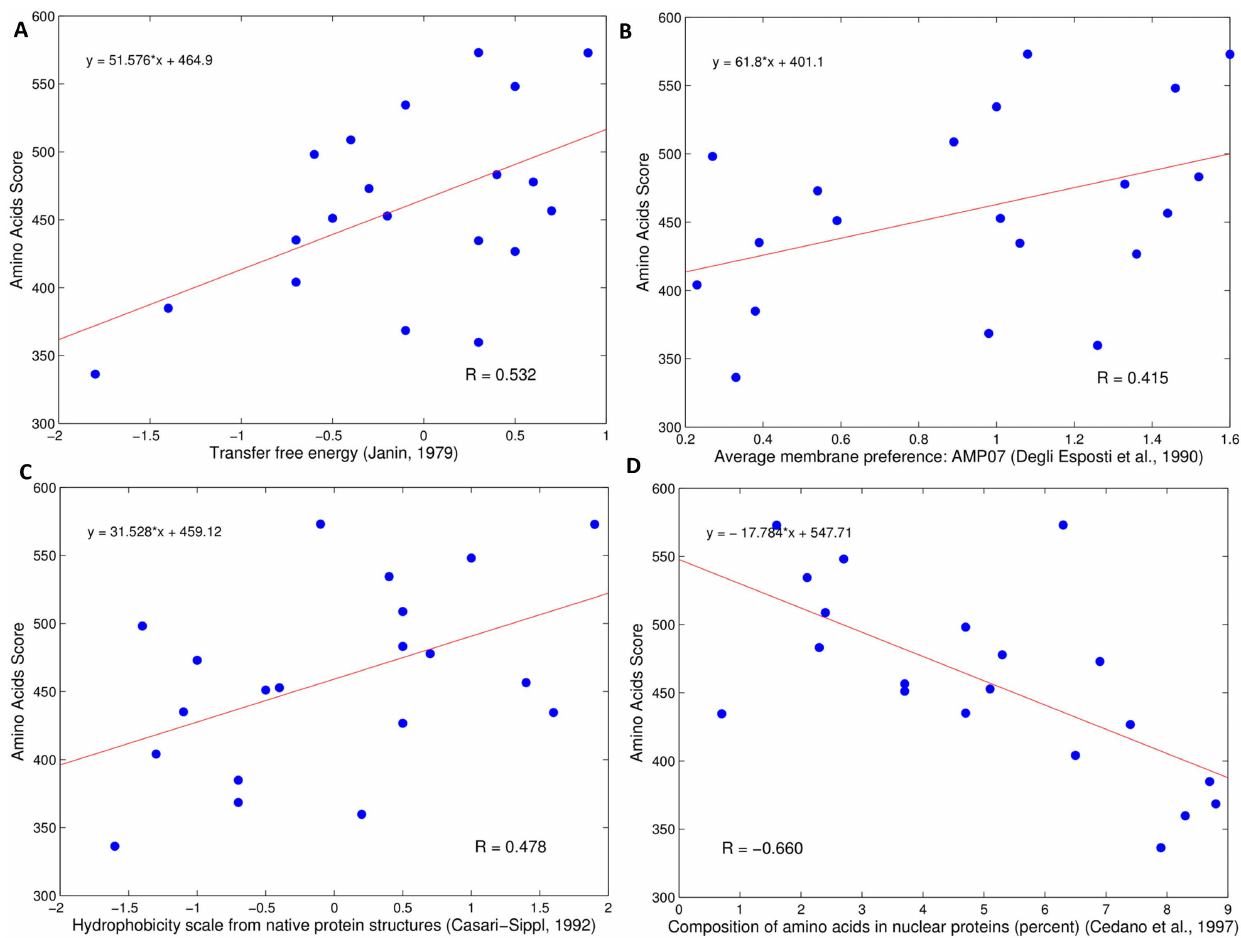
Figure 5. The correlation coefficients between the propensity scores and various physicochemical properties of 20 amino acids. (A) Transfer free energy (B) Average membrane preference (C) Hydrophobicity scale from native protein structures (D) Composition of amino acids in nuclear proteins.